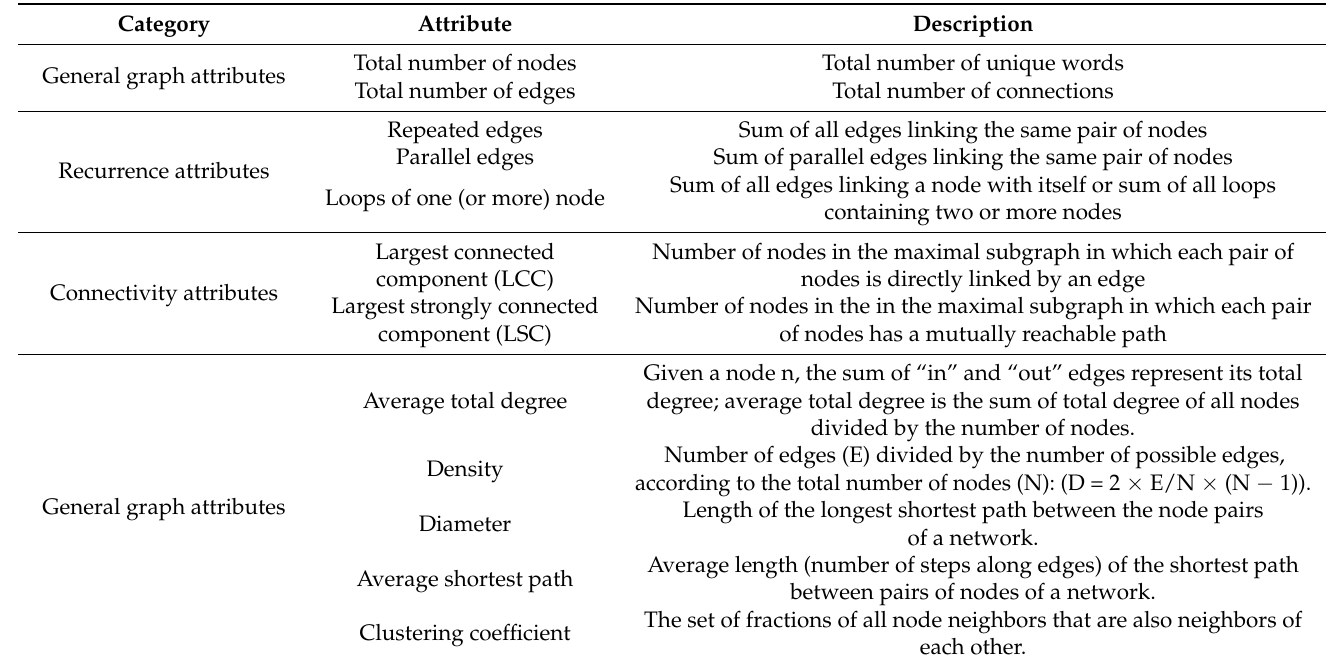
Table 1. The table describes the main mathematical attributes that were computed through graph analysis in the published literature on dream